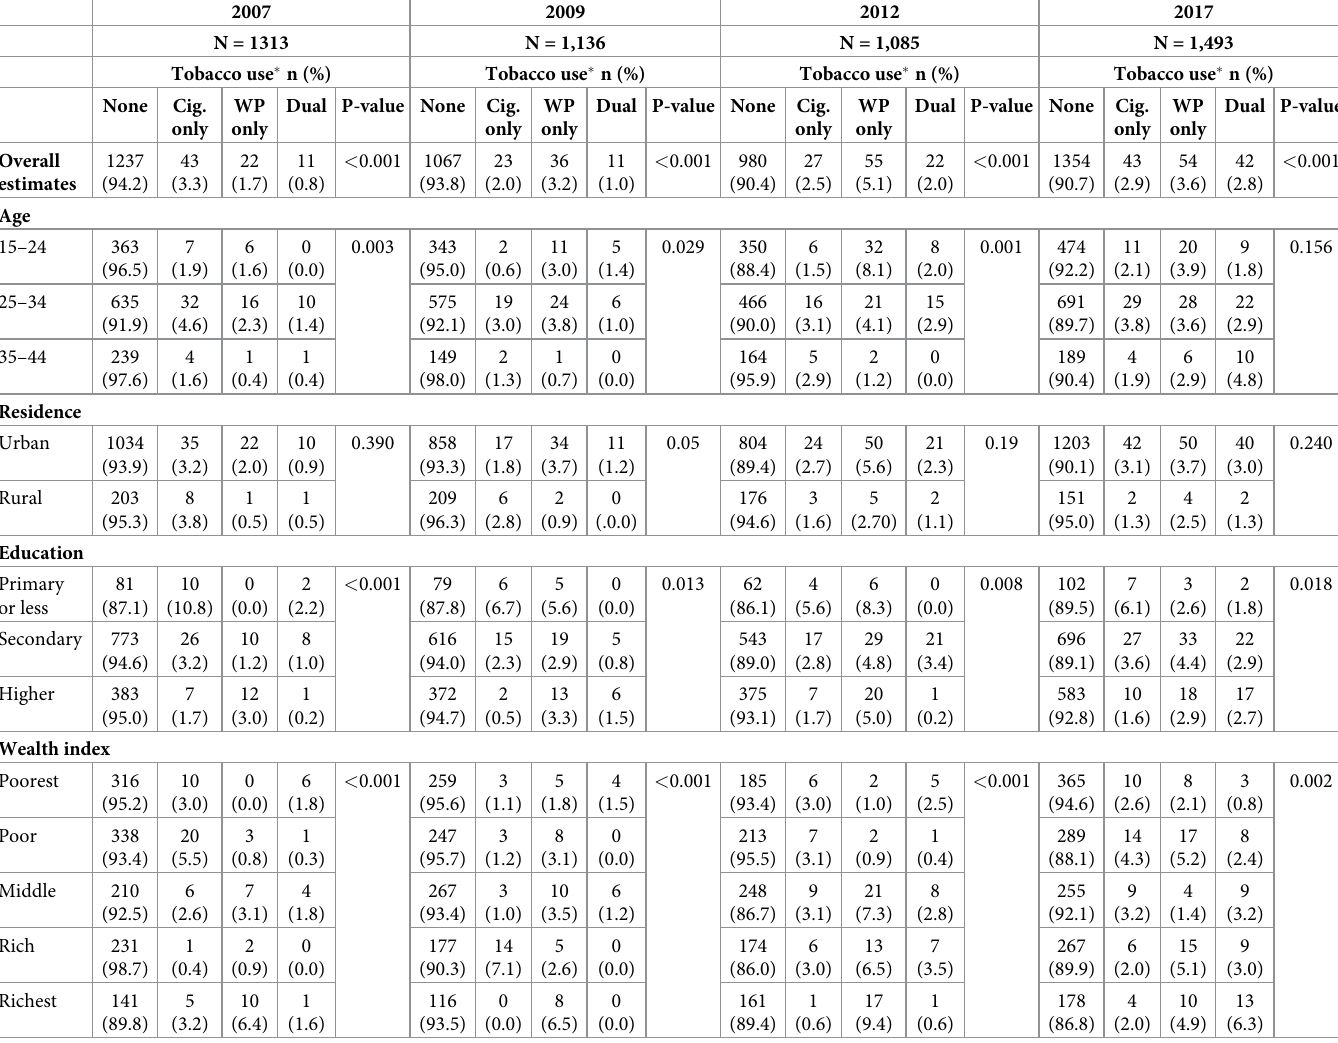
Table 4. Tobacco use by socio-demographics among pregnant women across the four waves of DHS